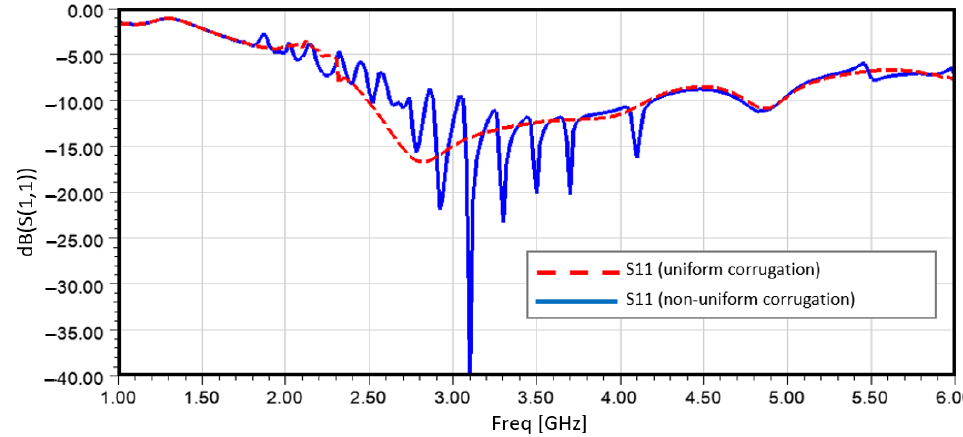
Figure 21. Effect of the type of corrugations on the reflection coefficient of the antenna.